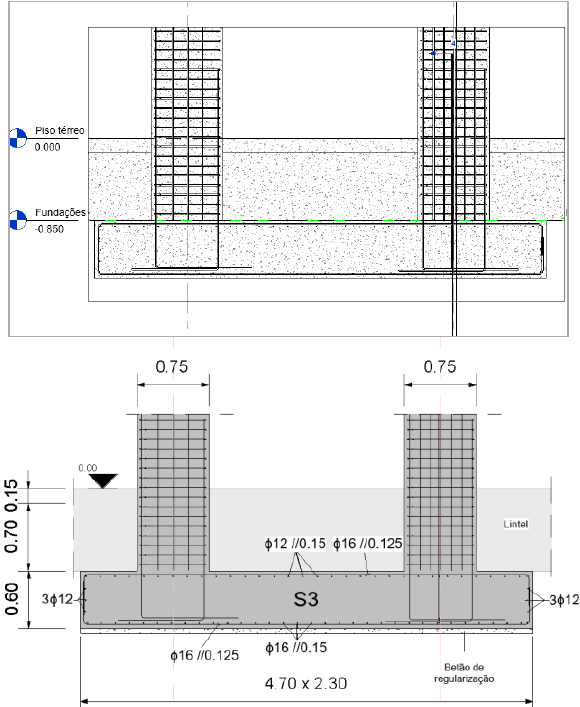
Figure 20. Drawing of a foundation element and columns before and after adjustment.